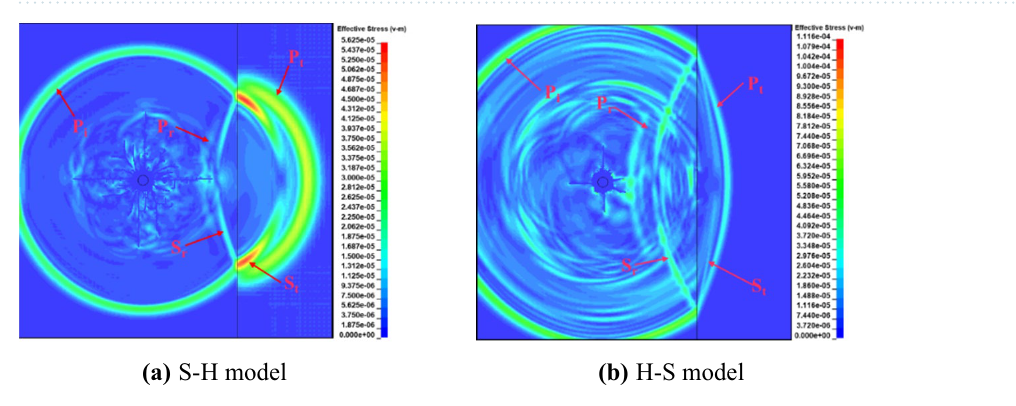
Figure 13. Effective stress cloud diagram of blasting